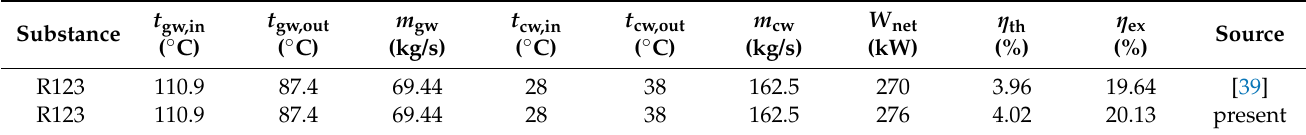
Table 2. Validation results compared with previously published data.